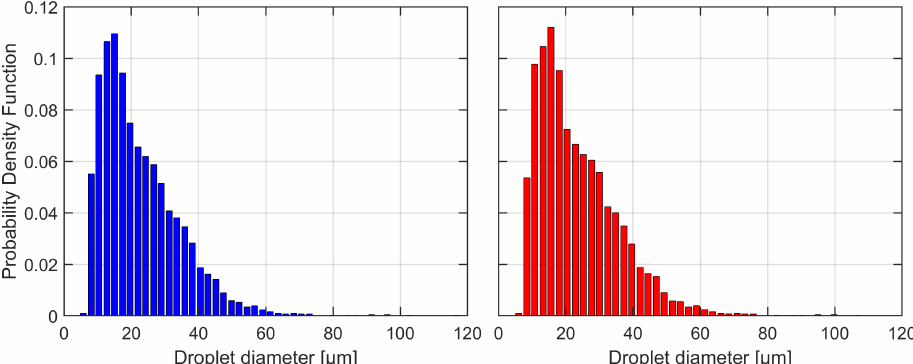
Figure 10. Histograms of droplet size distributions measured by the imaging system for an example droplet field generated by an air-operated nozzle. The left histogram was acquired with the droplet field illuminated by the LED light source, whereas the VCSEL system was used to generate the right